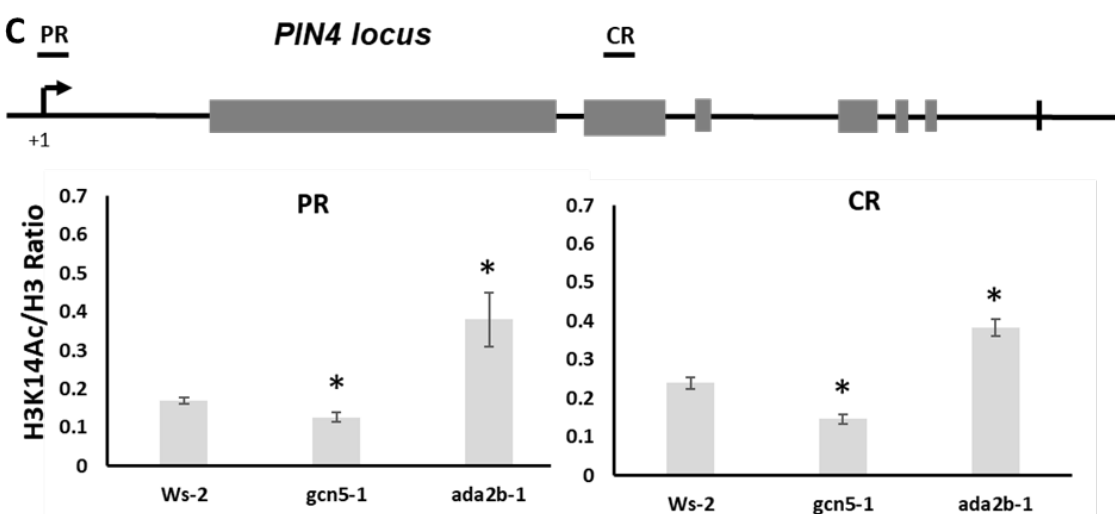
Figure 6. GCN5 and ADA2b affect histone acetylation of H3K14 of PIN genes. ChIP assays in roots of seven-day-old Ws-2, gcn5-1 , and ada2b-1 plants. The promoter (P) and the coding region (CR) were analyzed for each genomic locus as indicated by the line above the gene model. ( A ) PIN1 , ( B ) PIN3 , and ( C ) PIN4 loci were analyzed. Values are presented as a percentage of input. Asterisks indicate the statistical significance of three technical repeats compared to the wild-type, based on an independent samples t -test: * p < 0.05, ** p < 0.01, and *** p <